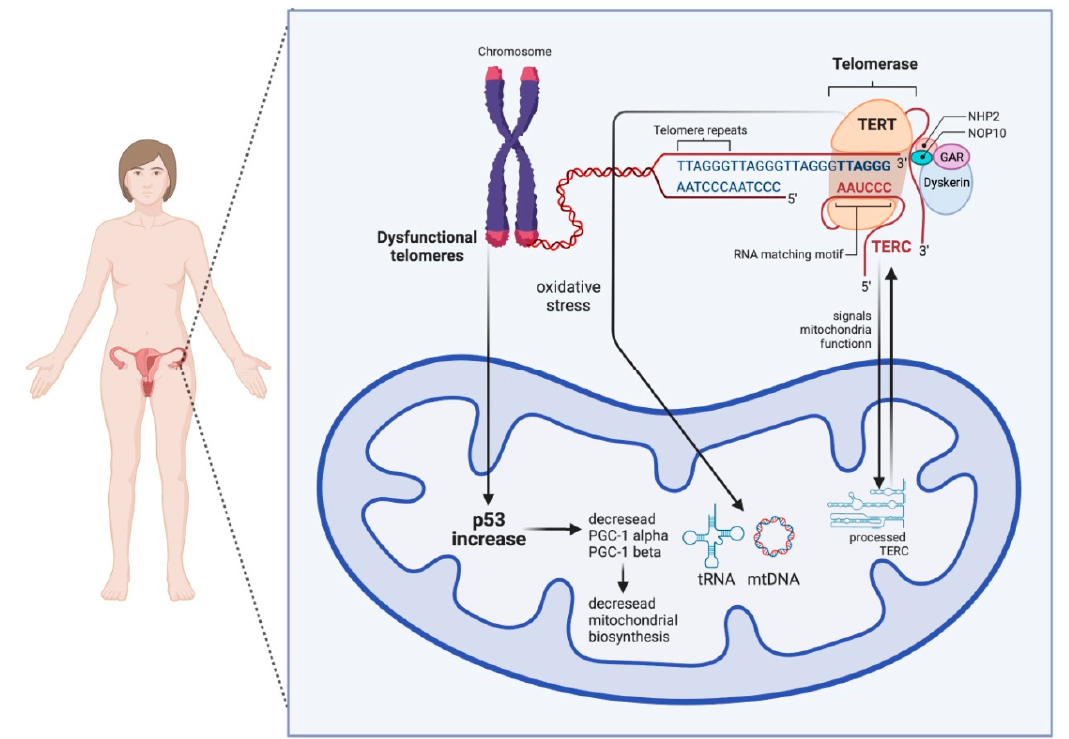
Figure 2. Scheme showing the bilateral crosstalk between telomeres and mitochondria in the ooplasm. On the one hand, telomere damage lowers mitochondrial biogenesis via the activation of p53, which, in consequence, negatively influences the PGC-1 α and PGC-1 β promoters. On the other hand, mitochondrial dysfunction can result in short and dysfunctional telomeres. TERT stands for telomerase reverse transcriptase and works as a catalytic subunit of the enzyme telomerase, and TERC stands for telomerase RNA component.